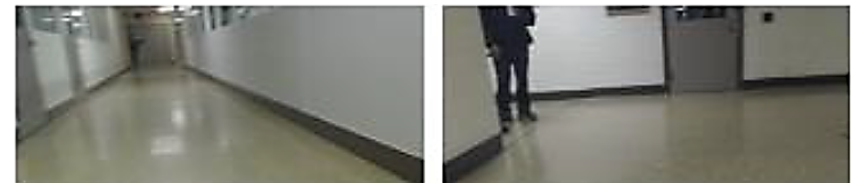
Figure 18. Examples of images collected from the camera.